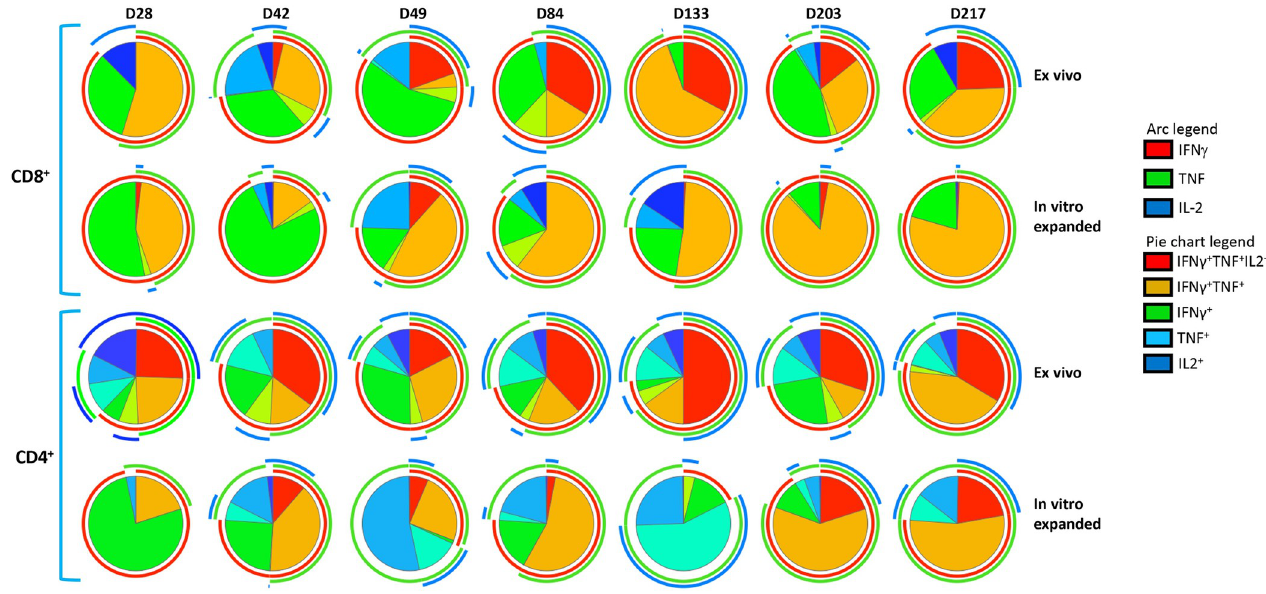
Fig 7. CMV vaccine induces long-term durable polyfunctional CMV-specific CD8+ and CD4+ T cell responses. In vitro expanded CMV-specific T cells from HLA A24 expressing mice were assessed for polyfunctional profile using multiparametric intracellular cytokine assay. These T cells were assessed for the expression of IFN γ , TNF and/or IL-2 simultaneously by flow cytometry in combination with SPICE software. Pie charts represent the proportion of CMV- specific CD8 + and CD4 + T cells expressing various combinations of IFN γ , TNF and/or IL2 cytokines after ex vivo and in vitro expansion. Arc indicates the proportion of CMV-specific CD8 + and CD4 + T cells expressing individual cytokines (IFN γ , TNF or IL-2).